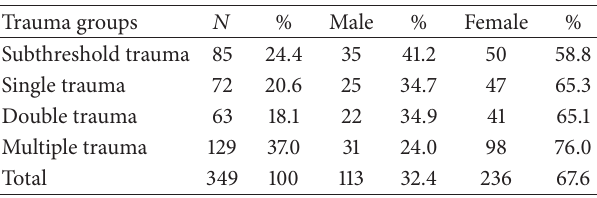
Table 4: Four trauma groups: subthreshold, single, double, and multiple